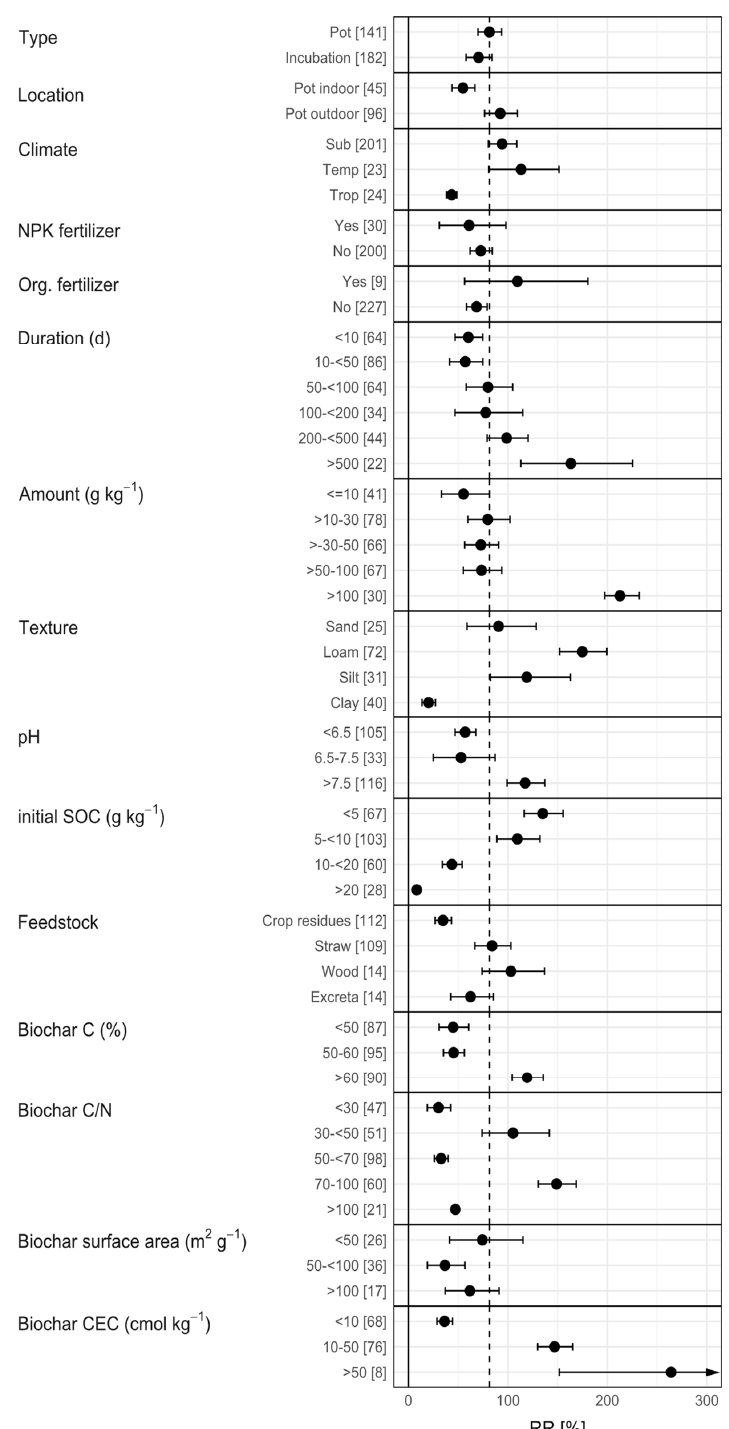
Figure 4. Meta-analysis results of the “non-field dataset”, given as a forest plot. Presented is the relative response ratio RR [%] of soil organic carbon content after the application of biochar influenced by different data groups. Numbers in brackets represent the number of included treatments. Points within the range represent the mean dSOC and the line within the 95% confidence interval represents the range of the effect size. If the effect size range crosses the “zero-effect-line”, given as a solid vertical line at 0%, the result can be interpreted as statistically insignificant. The effect sizes of each group were considered to be significantly different at p < 0.05 from each other if the 95% confidence intervals were not overlapping. The vertical dotted line represents the grand overall